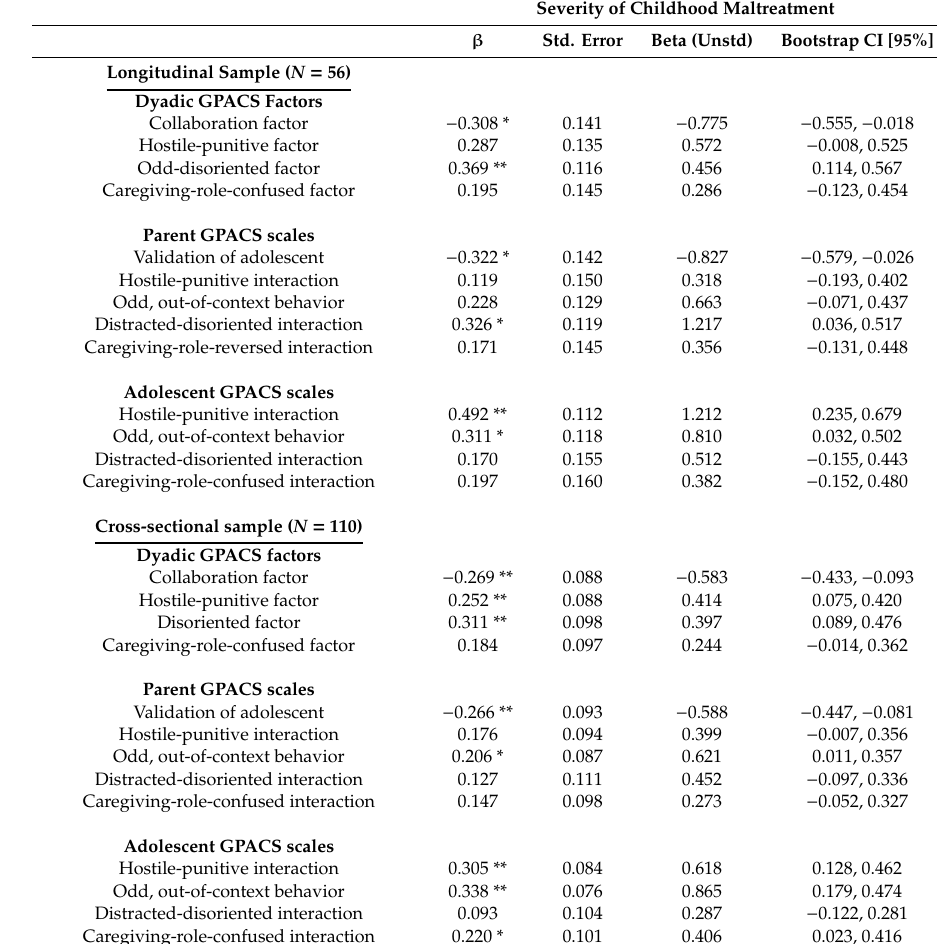
Table 4. Regression results for concurrent associations between indices of parent–adolescent interaction and severity of childhood